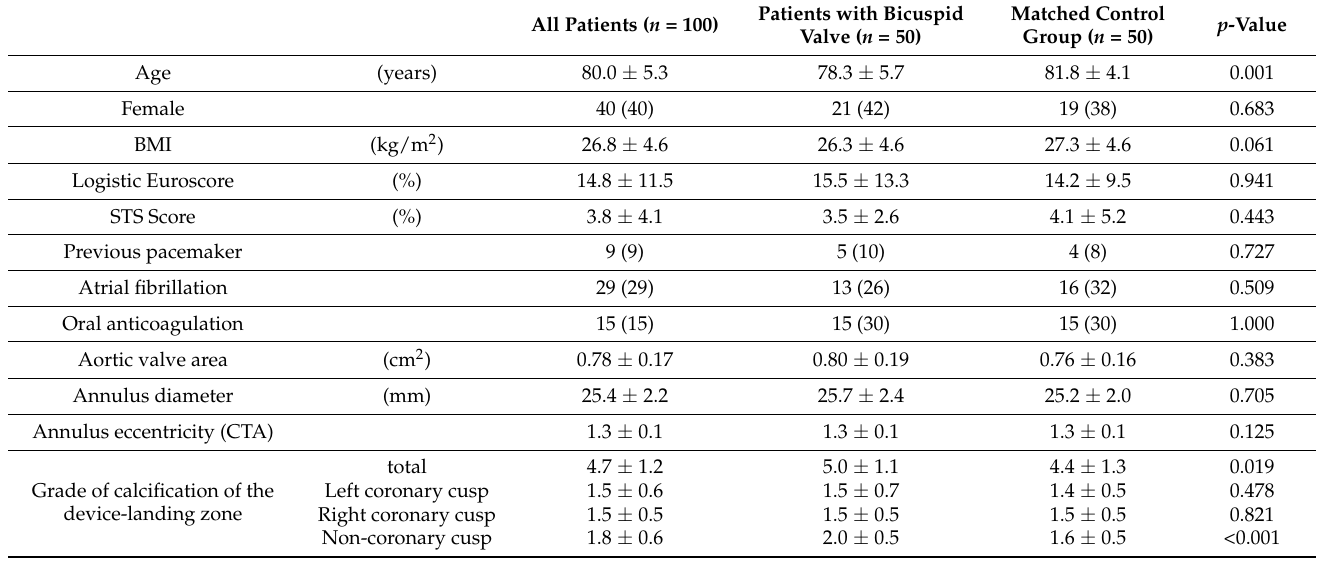
Table 1. Baseline, procedural and prosthesis-related characteristics of the entire study population, patients with bicuspid aortic valve, and the matched control